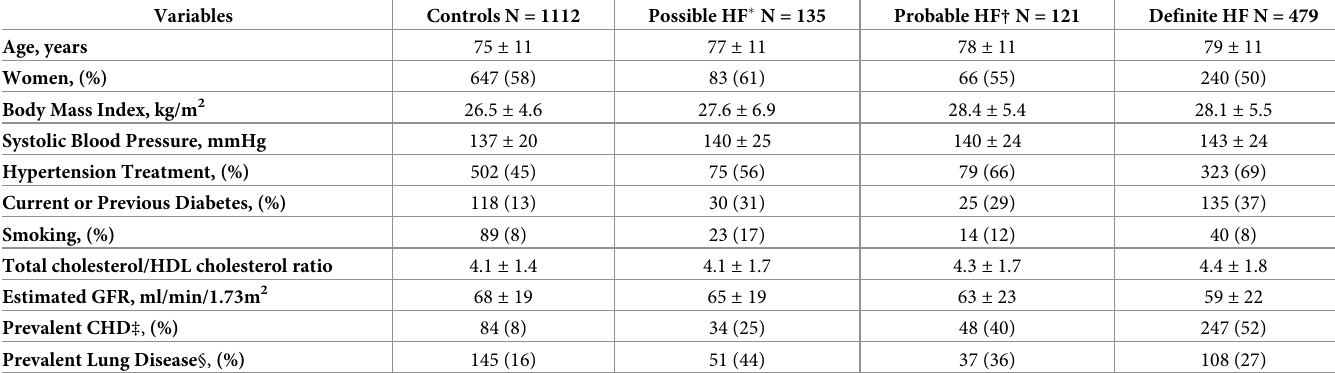
Table 1. Baseline characteristics of study participants.